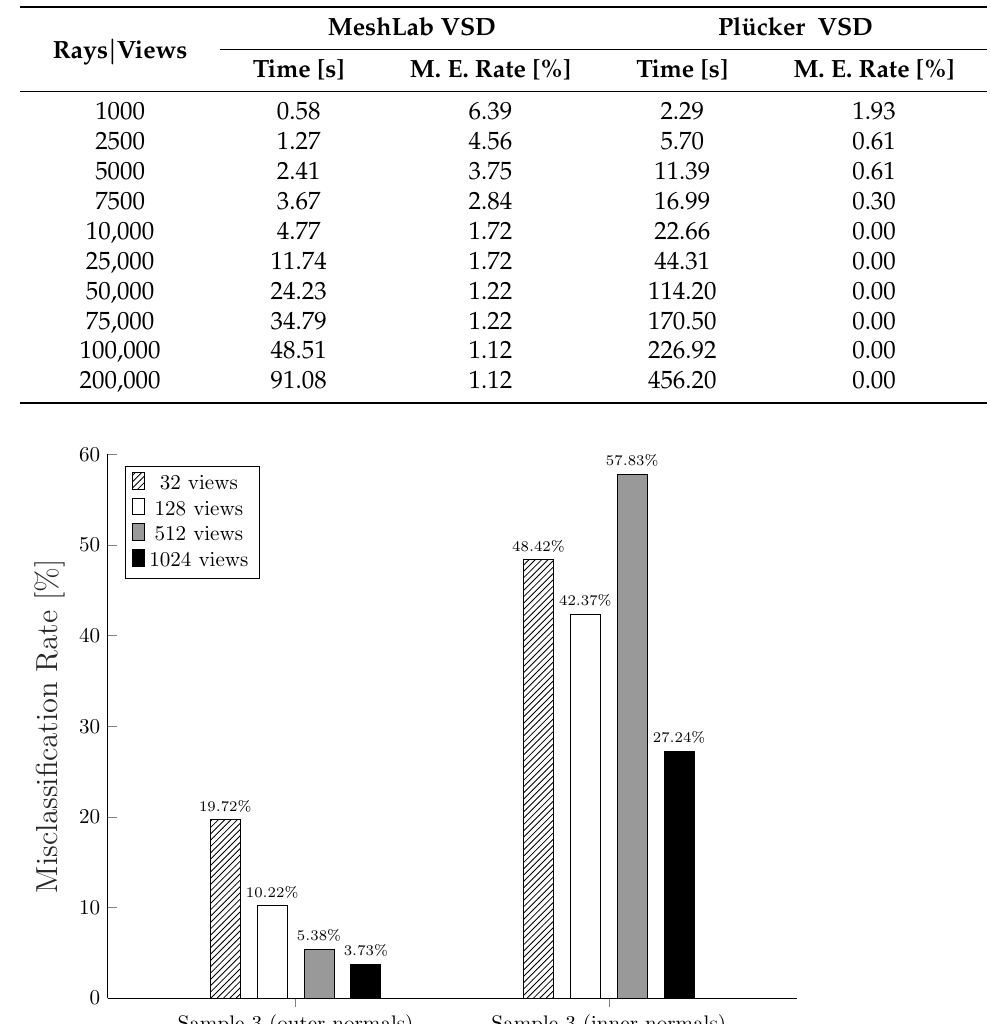
Table 1. Detail of times and misclassification rates of VSD performed on Sample 1 by the two algorithms.